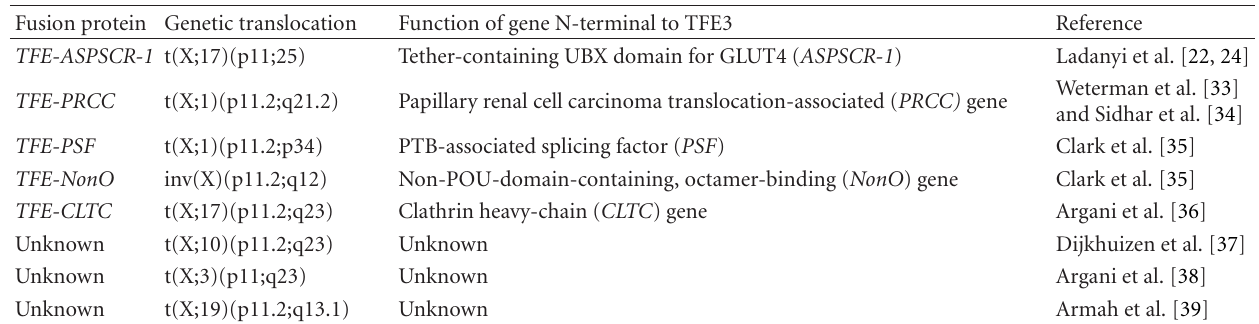
Table 1: Translocations involving the TFE3